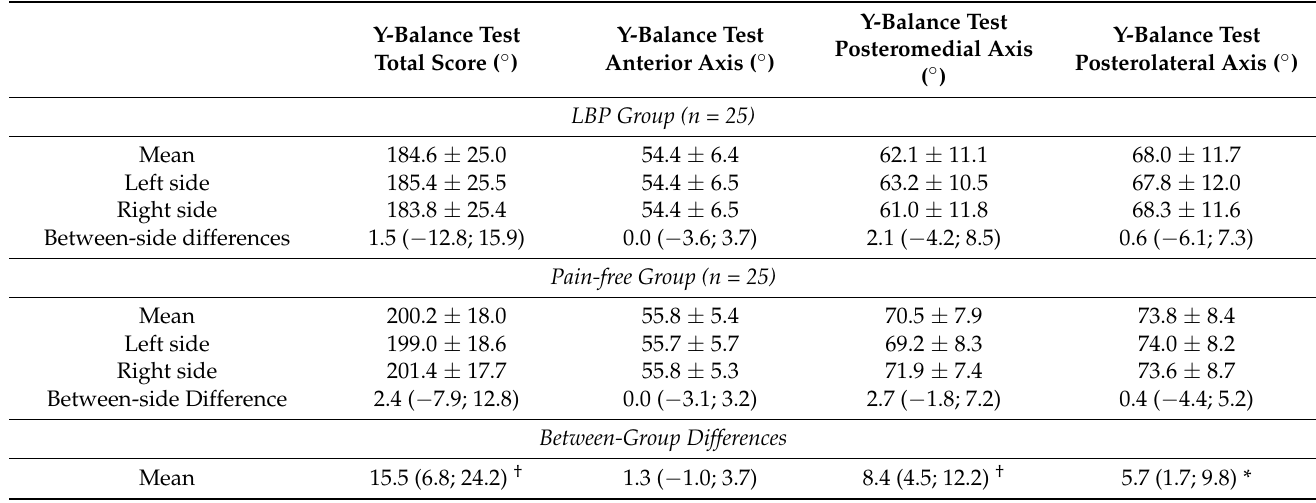
Table 3. Participants characteristics at baseline.